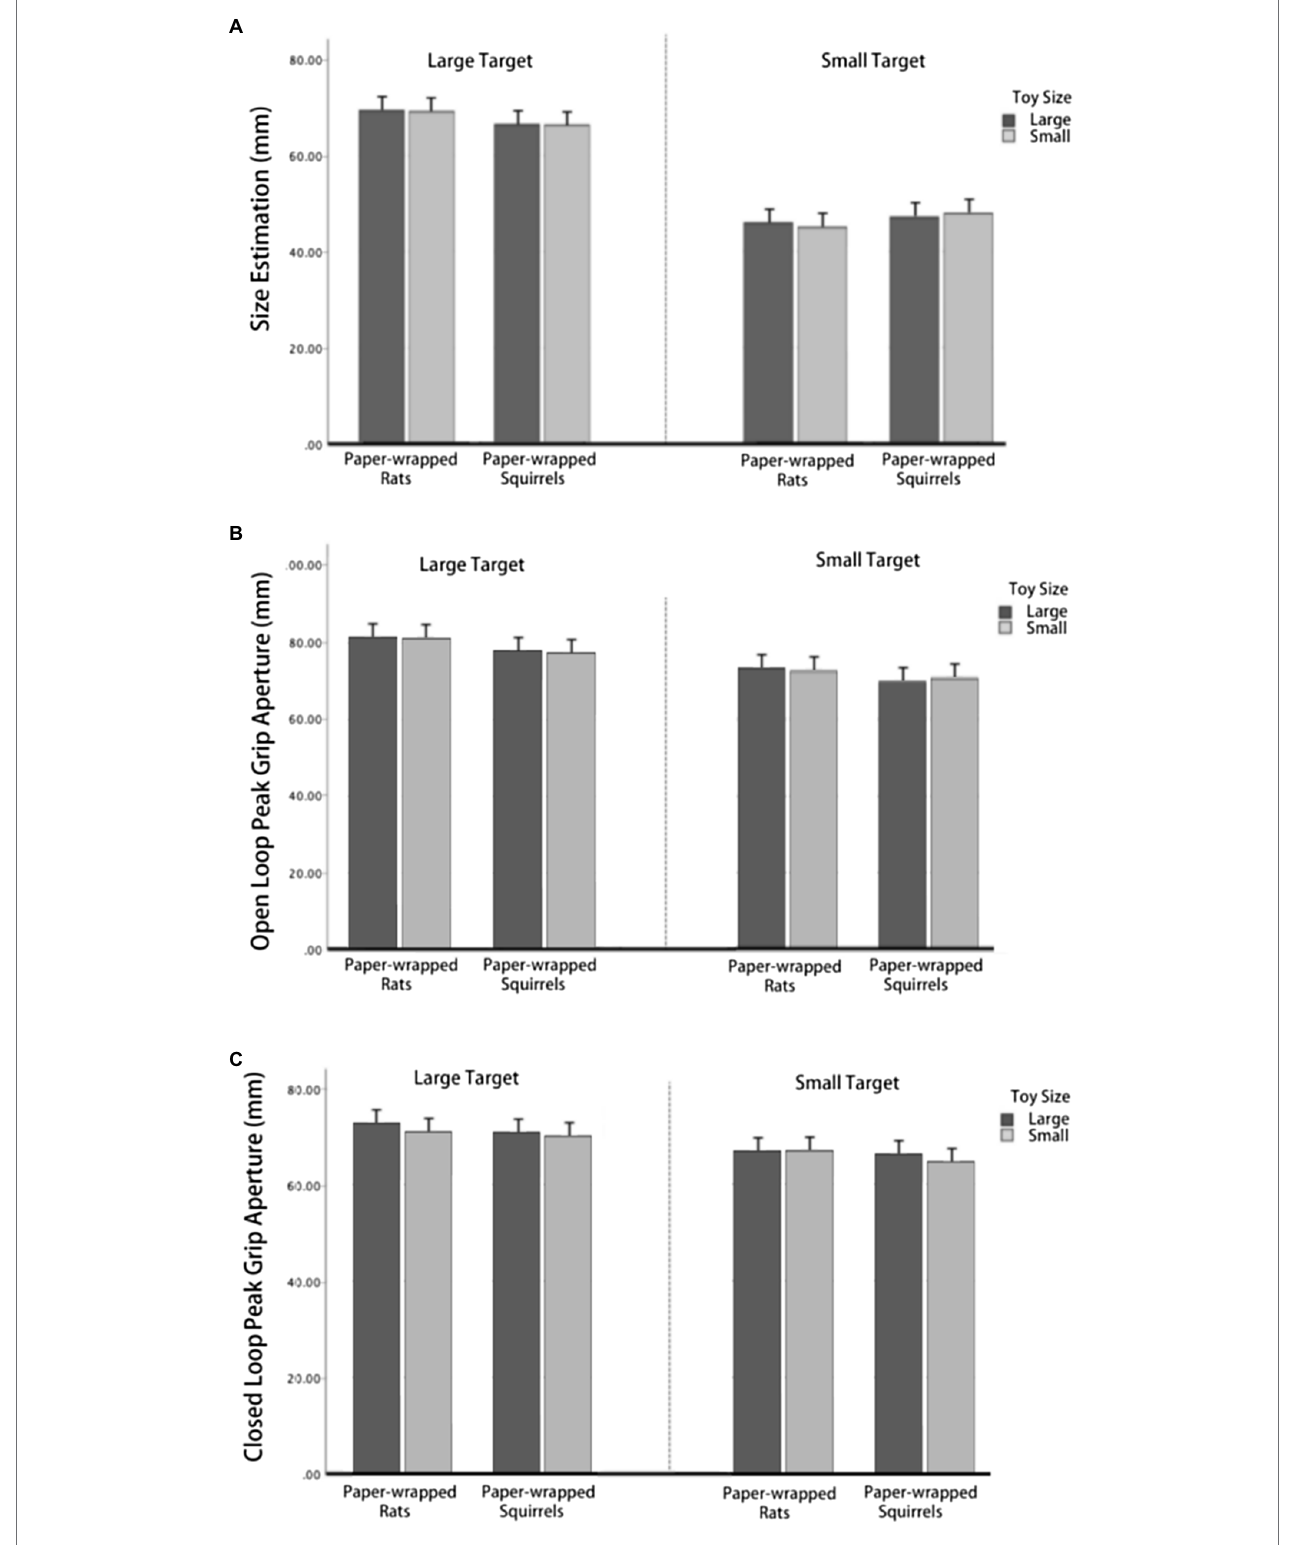
FIGURE 5 | Results of Experiment 3. (A) Size estimation when paper-wrapped toys were used as inducers. (B) Peak grip aperture when paper-wrapped toys were used as inducers in open-loop condition. (C) Peak grip aperture when paper-wrapped toys were used as inducers in closed-loop